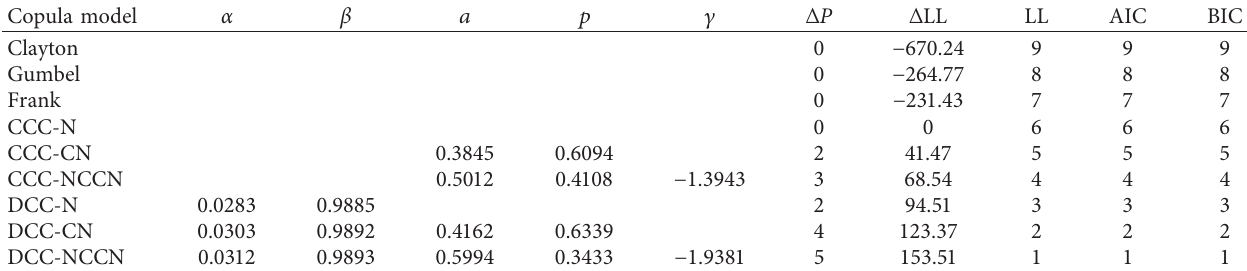
Table 8: Fitting results of bivariate copula models (HSI-CCI).